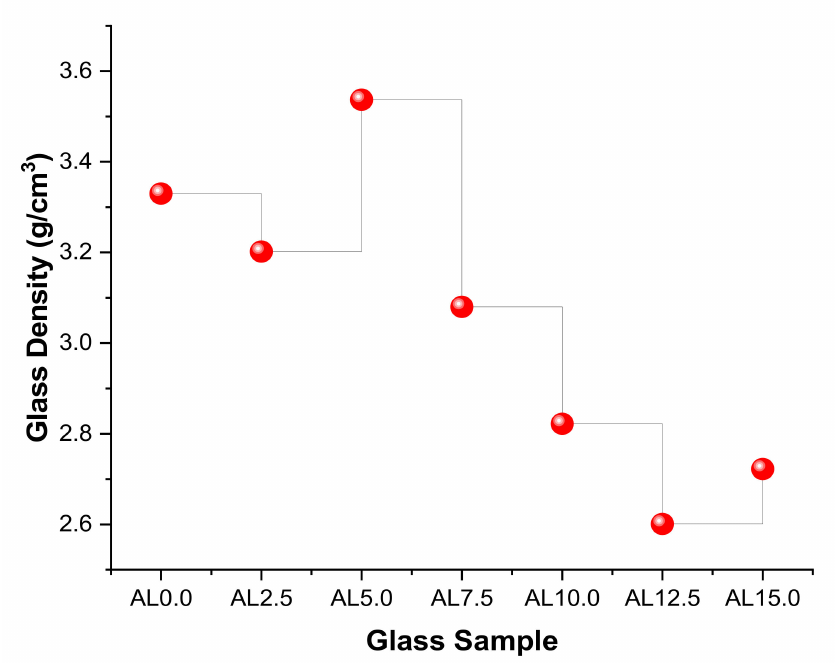
Figure 3. Variation of glass densities as a function of glass type (i.e., Al 2 O 3 %mole).